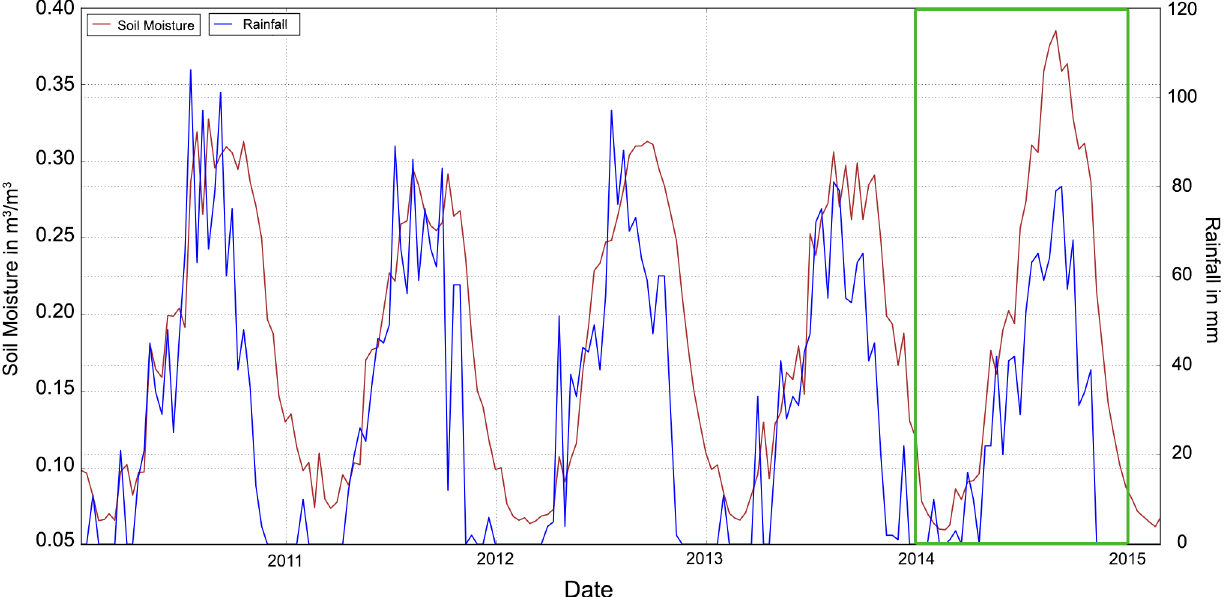
Fig 4. Satellite-derived time series of rainfall (blue) and soil moisture (brown) for the location of Kabo (18.61E/7.69N), covering January 2010 to May 2015 (the green rectangle highlights